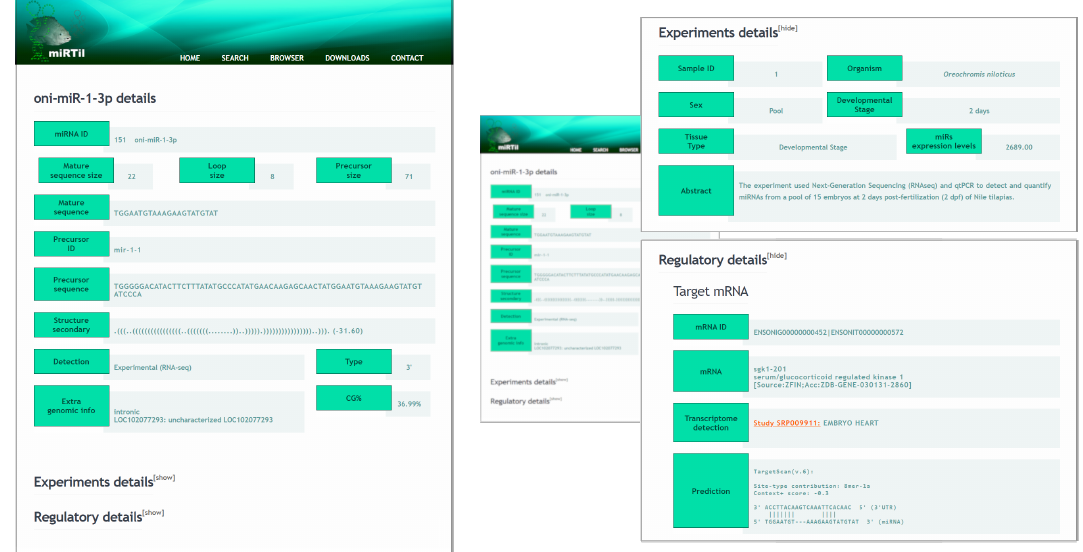
Figure 7. miRTil detailed results pages. The expanded page containing detailed miRNA information, such as identification and classification information, including structural and genomic location information. Extra menus can access hidden details about miRNA experimental and regulatory